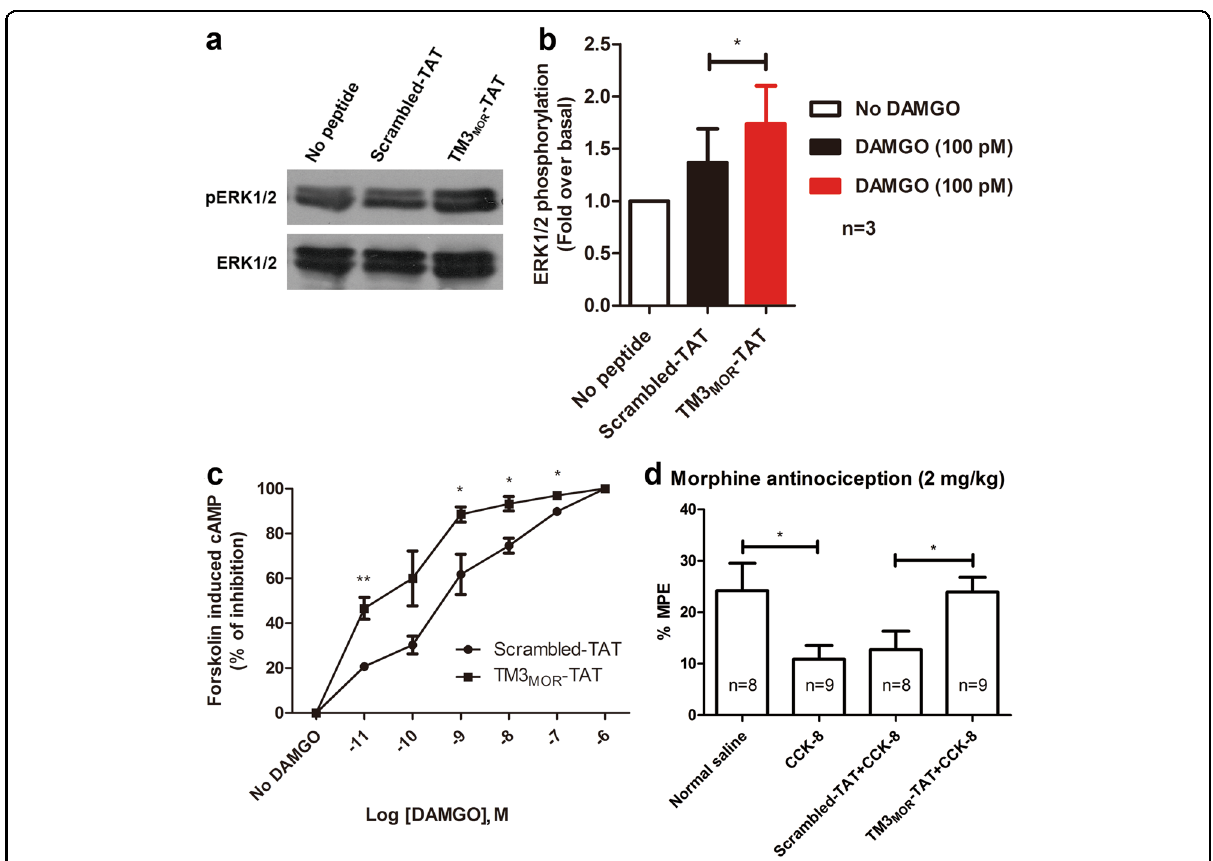
Fig. 7 The TM3 MOR -TAT peptide rescued MOR activity by disrupting the MOR – CCKBR interaction and remitted CCK-8-induced antagonism to morphine analgesia. a A representative result of ERK1/2 phosphorylation immunoblot assay. The top panel showed phosphorylated ERK1/2 bands, and the bottom panel showed total ERK1/2 bands. b Statistical results. The gray density values of the bands were obtained by Quantity One software and analyzed with GraphPad Prism 5.0 after gray density values normalized. Compared with the scrambled-TAT treatment, the TM3 MOR -TAT treatment signi fi cantly increased the phosphorylation of ERK1/2. * p < 0.05, t -test, n = 3. Data are expressed as the mean ± SEM. c TM3 MOR -TAT pretreatment enhanced DAMGO-induced inhibition of cAMP accumulation. d TM3 MOR -TAT reversed CCK-8 antagonism to morphine analgesia. Percent of maximum possible effect (%MPE) 30 min after morphine (2 mg/kg, s.c.) application. Compared with saline group, CCK-8 (i.t.) pretreatment decreased the analgesic effects of morphine. However, pretreatment with TM3 MOR -TAT 4 h before CCK-8 and morphine injection showed signi fi cantly stronger analgesic effects compared to that with scrambled-TAT pretreatment. * p < 0.05, t- test. Data are represented as the mean ±